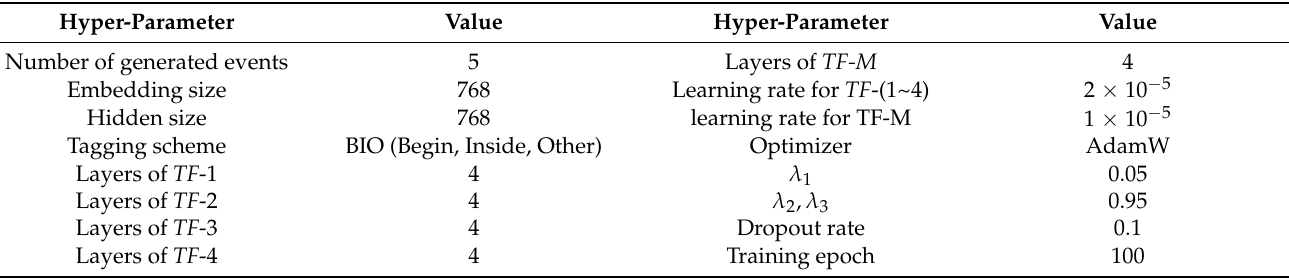
Table 1. The hyper-parameter